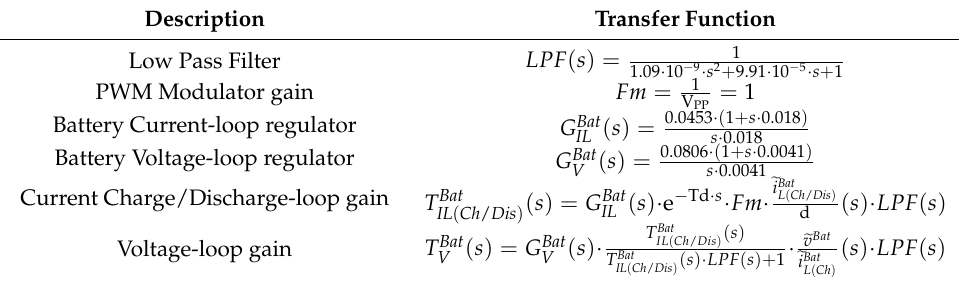
Figure 6. Bode plots of the loop gains: ( a ) Current loop for different values of the DC-bus voltage and ( b ) Voltage loop for different values of the SOC. Table 4. Transfer functions of the BESS controllers and loop gains.